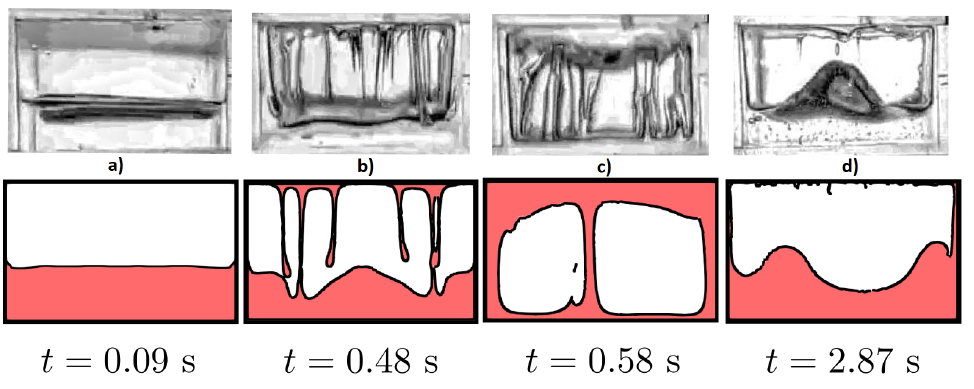
Figure 6. Experimental snapshots ( top ) of a vertical sloshing experiment with glycerine at a 39% filling level and 10 g of maximum acceleration. Numerical counterparts ( bottom ) simulated the δ -SPH